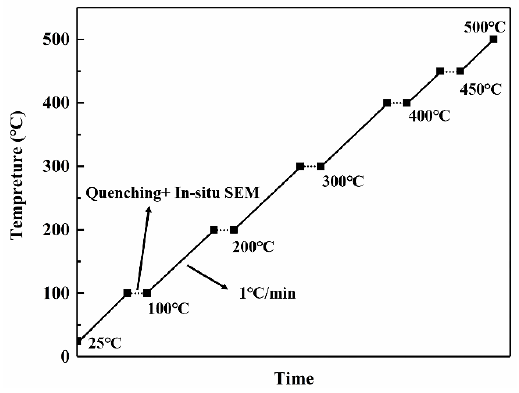
Figure 1. Schematic diagram of homogenization procedure.